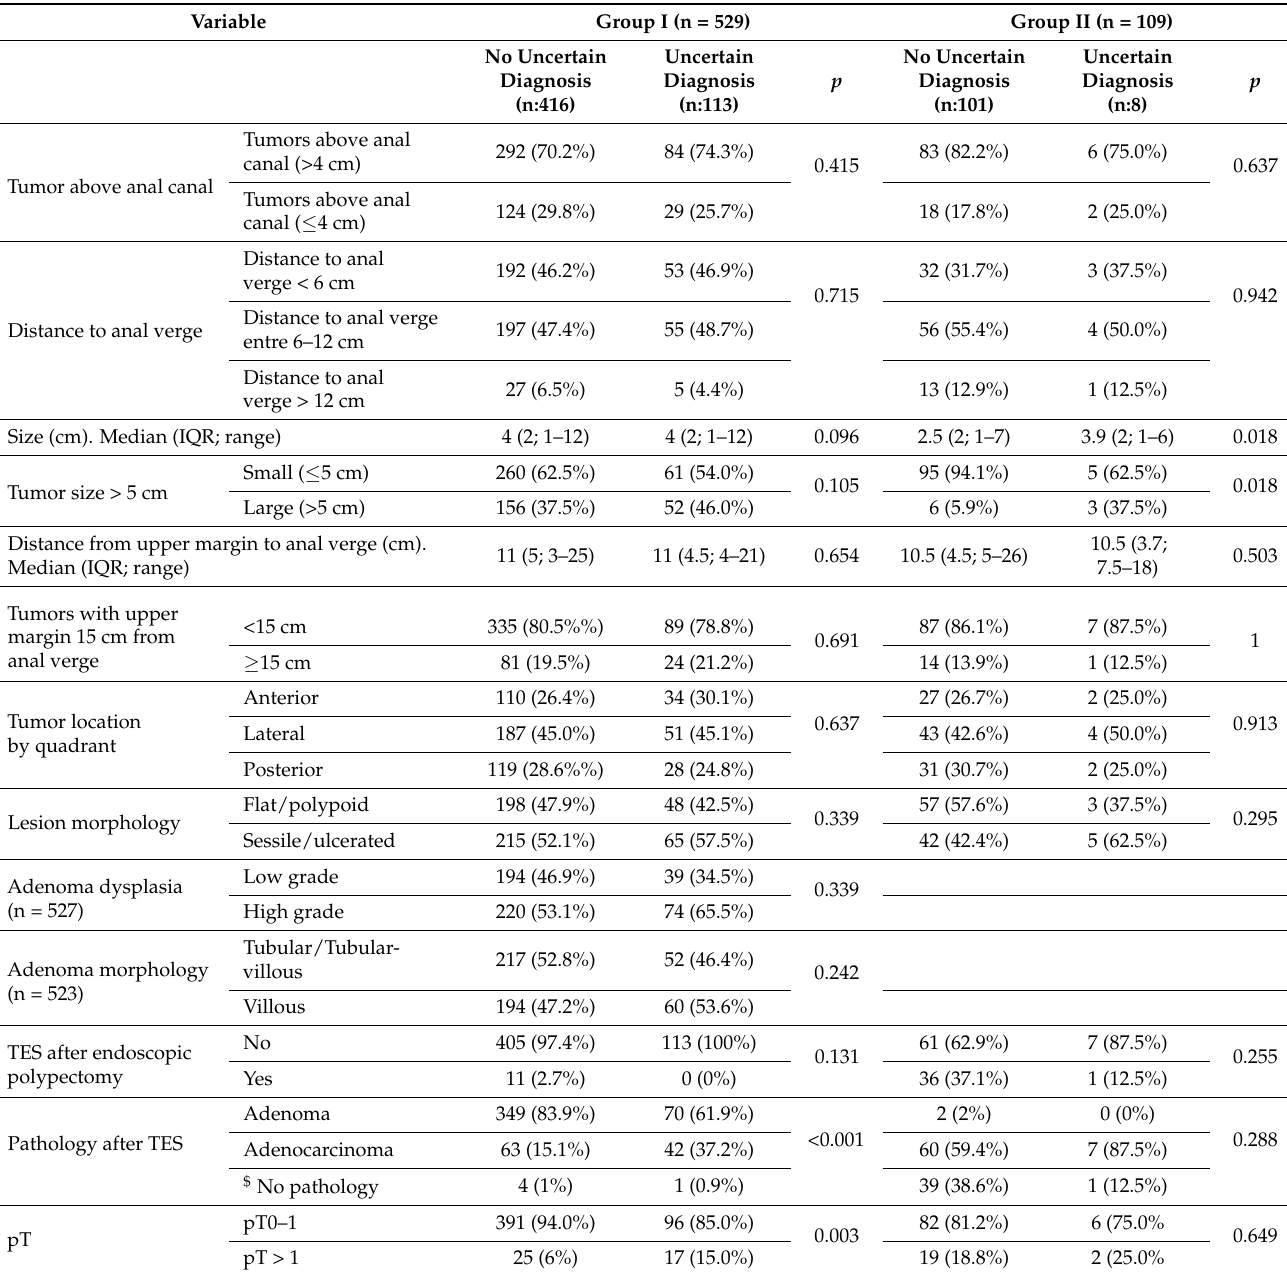
Table 4 assesses patient and tumor variables related to the definitive